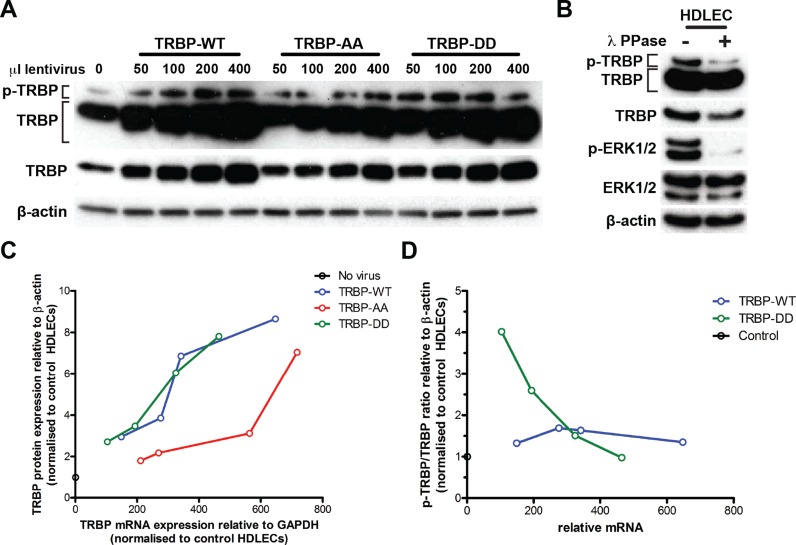
TRBP serines 283/286 control TRBP expression and post-translational modification. (A) Phosphorylated (p-TRBP) and total TRBP expression in HDLECs transduced (3 days, full media; see Materials and Methods) with the indicated volumes of lentiviruses (per 80 000 cells) encoding for TRBP-WT, TRBP-AA and TRBP-DD mutants. The top two rows of the immunoblots correspond to high (10–15 min) and low (1 min) exposure of the TRBP immunoblot, respectively. The band corresponding to hyper-phosphorylated TRBP is indicated as pTRBP. (B) Immunoblots showing TRBP and phosphorylated TRBP and phosphorylated ERK1/2 after lamda (λ) phosphatase treatment of HDLEC protein lysates. (C) Graph showing TRBP mRNA and protein levels for HDLECs transduced with 50, 100, 200, and 400 μl TRBP-WT, TRBP-AA, and TRBP-DD lentiviruses (per 80 000 cells, see Figure 7A). Levels are shown as fold induction compared to endogenous TRBP levels (no virus). (D) Graph showing the ratio of phosphorylated to total TRBP against TRBP mRNA levels for HDLECs transduced with TRBP-WT, and TRBP-DD lentiviruses. Levels are shown as fold induction compared to endogenous TRBP levels (no virus).